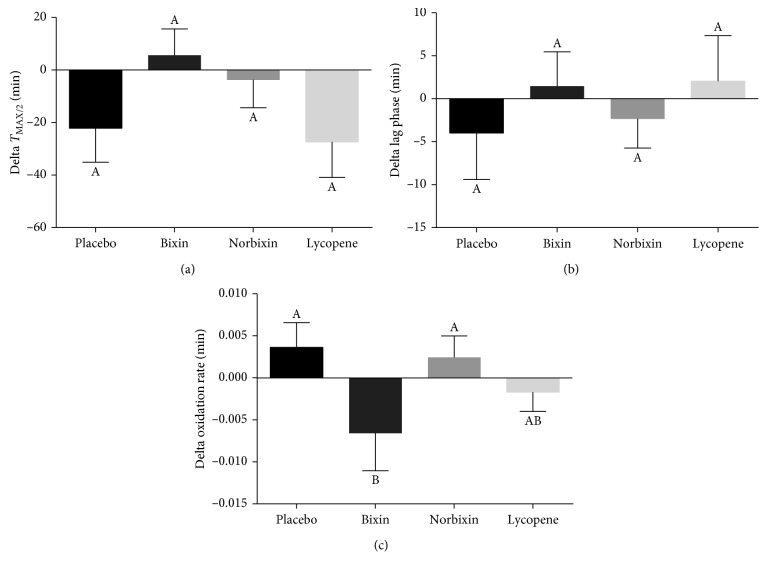
Effect of carotenoid supplementation on the susceptibility of LDL to Cu2+-induced oxidation ex vivo. The oxidation of the protein moiety was assessed as the time required to lose half-maximal tryptophan fluorescence (a), whereas the oxidation of the lipid moiety was assessed as the lag time for the formation of conjugated dienes (b) and the oxidation rate (c). Results (mean ± SEM) are presented as the delta values between final and baseline values. Different letters indicate a significant difference among treatments (p < 0.1).